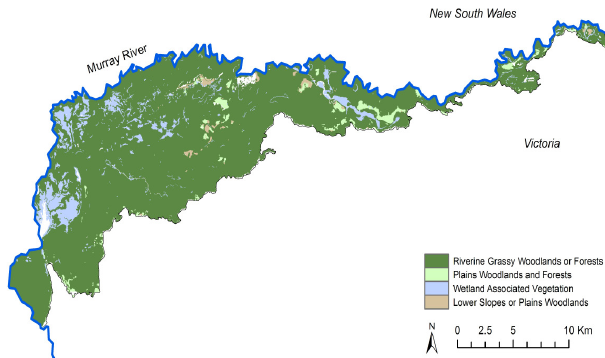
Figure 1. Distribution of Ecological Vegetation Class Groups within the Barmah